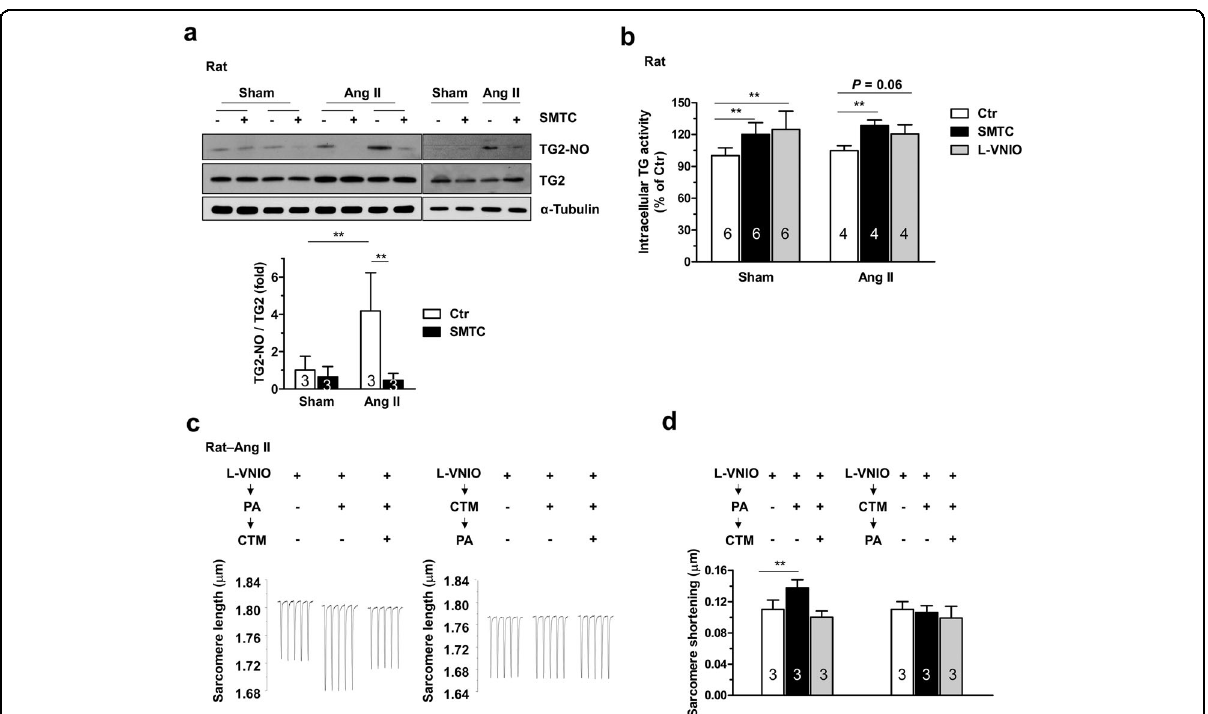
Fig. 5 S -nitrosylated TG2 is increased in cardiomyocytes from Ang II-treated rats. a Immunoblot showing S-nitrosylated TG2 (TG2-SNO) levels on treatment with SMTC (100 nM), a nNOS inhibitor, in LV myocytes from three sham and three Ang II-treated rats (left). Signals were quanti fi ed by densitometry and normalized to total TG2 levels (right, TG2-SNO/TG2). b Effects of SMTC (100 nM) or L-VNIO (100 μ M) on TG2 activity in LV myocytes from sham and Ang II-treated rats. c , d Effects of L-VNIO and/or CTM on PA-dependent contraction in LV myocytes from Ang II-treated rats. A representative graph is shown c . The difference between diastolic and systolic sarcomere length ( Δ sarcomere shortening) was compared ( d ). Data represent mean ± S.D. ** P < 0.01 compared with